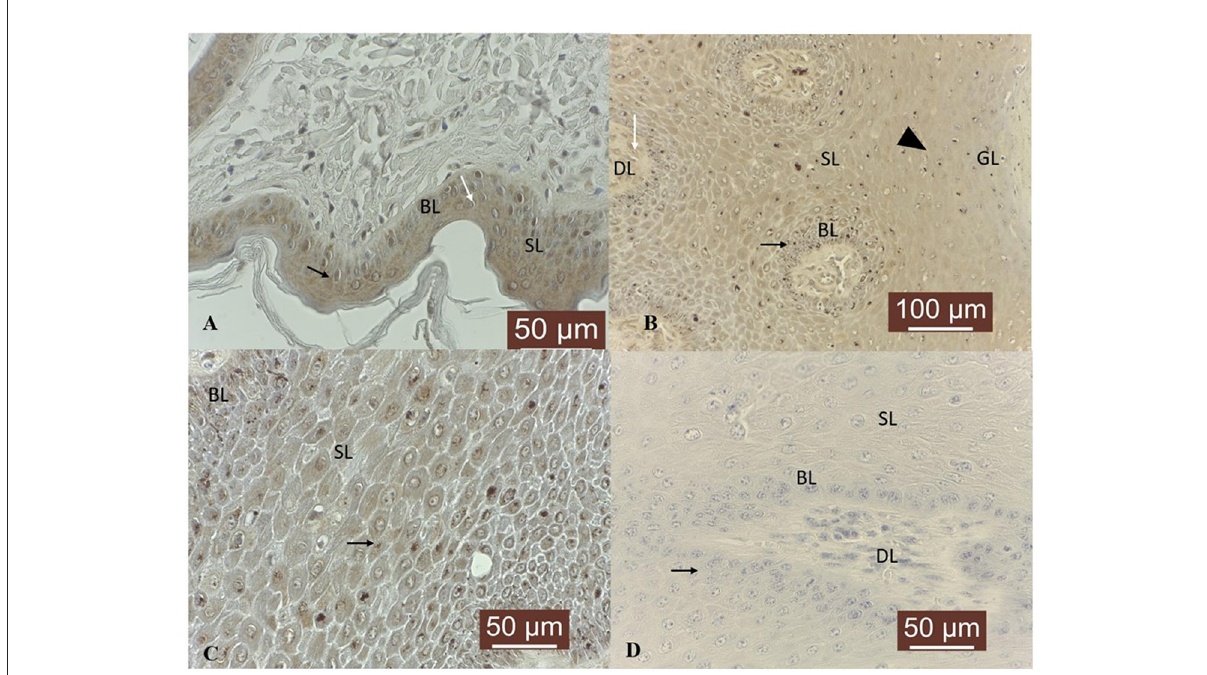
FIGURE5 MMP-14 immunostaining in bovine normal skin and fibropapillomas: (A) In normal skin samples, MMP-14 showed a specific immunoreactivity in a cytoplasmic, perinuclear (black arrow) and nuclear (white arrow) pattern in basal (BL) and spinosum (SL) epithelial cell; 40 X. (B) In fibropapillomas, MMP-14 was moderate expressed in cytoplasm (black arrow) of cells from basal (BL), spinosum (SL) and granular (GL) (black arrowhead) layers, while the fibroblasts from dermal layer (DL) showed a weak positivity (white arrow); 20 X. (C) Note a detailed fine granular cytoplasmic, perinuclear (black arrow) and nuclear pattern in tumor keratinocytes from BL and SL; 40 X. (D) Negative control: fibropapilloma with the first antibody anti-MMP-14 omitted and incubated with secondary antibody did not stain; 40